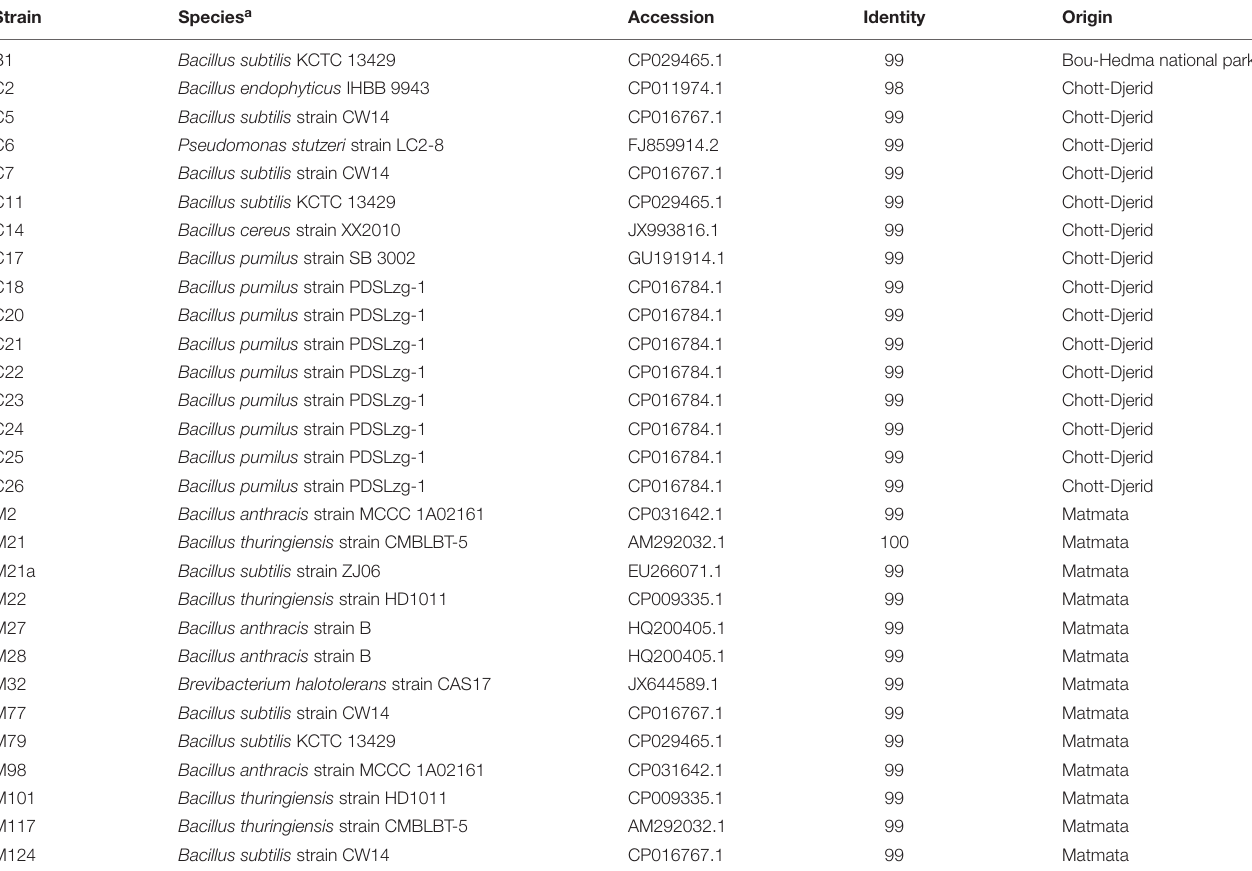
TABLE 1 | Closest relative of the 29 bioactive soil isolates based on 16S rDNA sequence. Strain